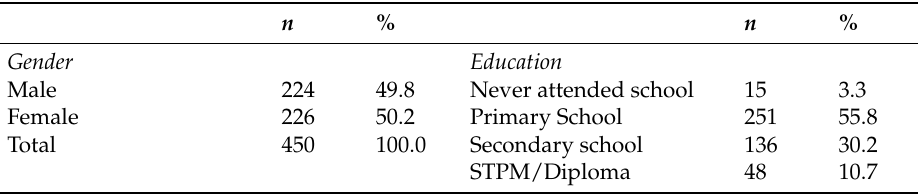
Table 1. Profile of the